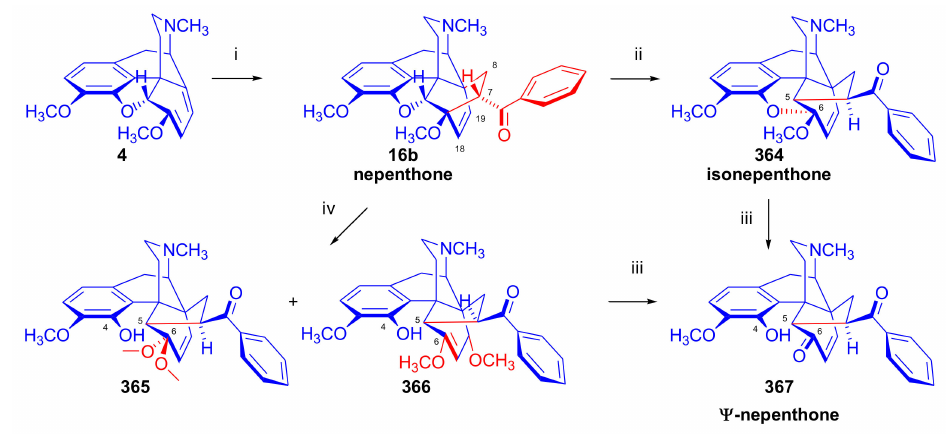
Figure 93. Synthesis of nepenthone and its rearranged derivatives. Reagents and conditions : (i): phenyl vinyl ketone, benzene, reflux, 2 h, 70%; (ii): NaOH, MeOH, reflux, 5–10 min., 75%; (iii): 5% HCl or AcOH; and (iv): NaOH, MeOH, reflux, 4